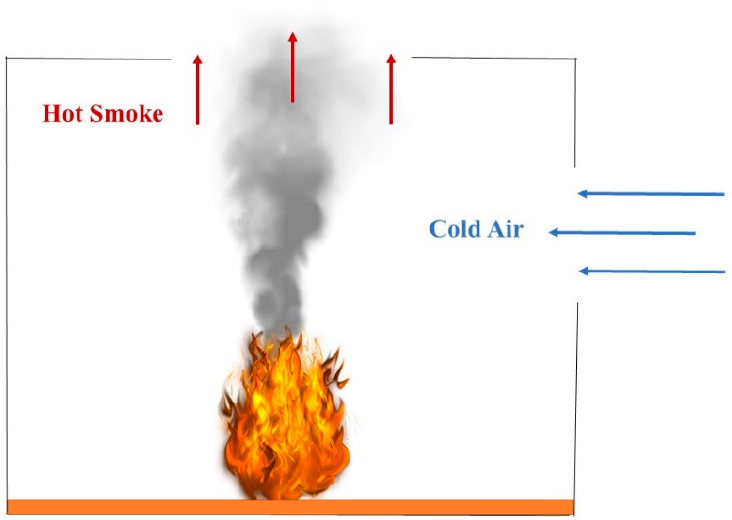
Figure 5. Vent flows based on Magnusson et al.’s approximations [31].